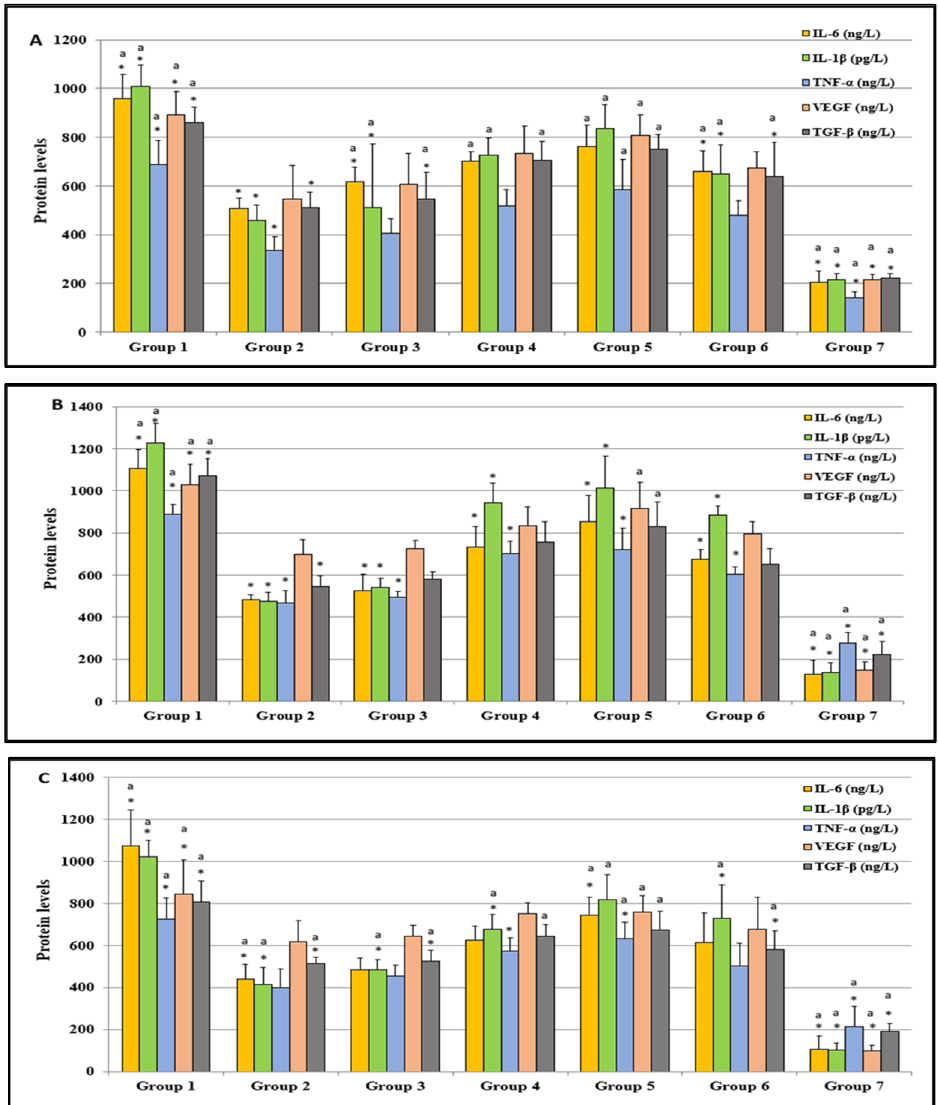
Figure 4. The inflammatory cytokines (IL-1 β , IL-6, and TNF- α ) and other inflammatory mediators (VEGF and TGF- β ) in the serum ( A ), stomach tissues ( B ), and liver tissues ( C ) of all groups were studied. Values are expressed as means ± SD of seven rats ( n = 7) from each group. * Values differed for the group 1 significantly at p ≤ 0.001. a Values differed for the group 7 (control) significantly at p ≤ 0.001.